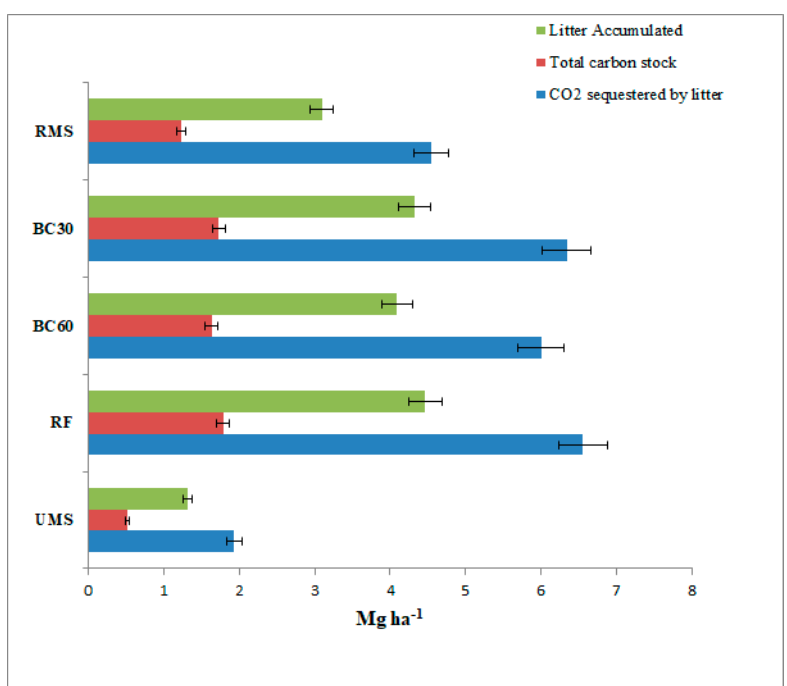
Figure 6. Litter and understory carbon stock in reclaimed mine spoil (RMS), biochar treatment at 30 t ha − 1 (BC 30 ) and 60 t ha − 1 (BC 60 ), reserved forest (RF) and unreclaimed mine spoil (UMS) ( n = 24).